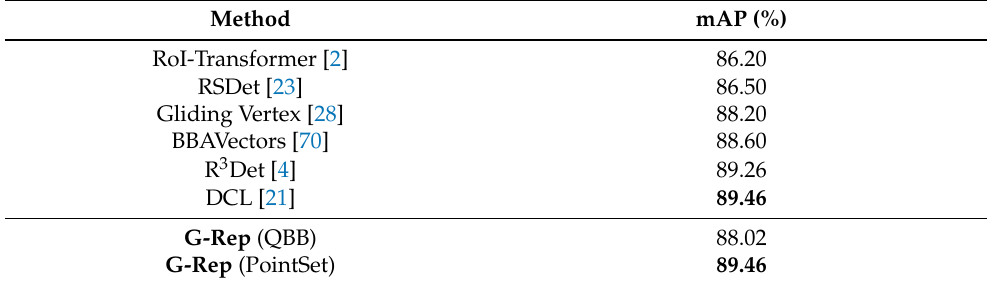
Table 8. Comparison of the mAP of various rotation methods on HRSC2016.